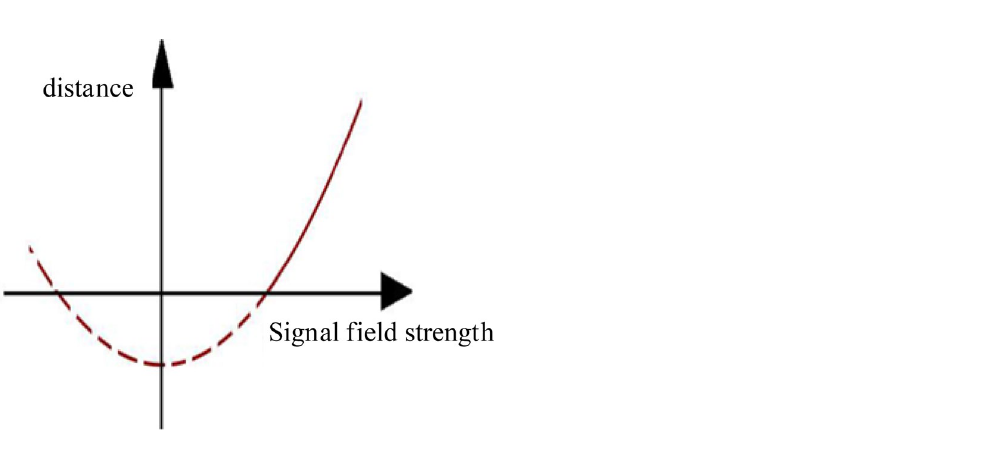
Figure 9. Parabolic graph of distance and wireless signal